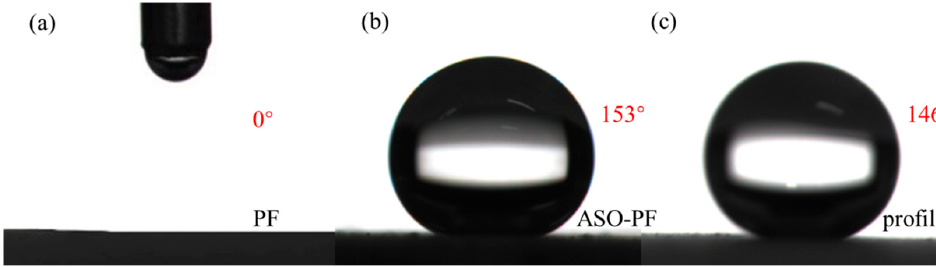
Figure 5. Water contact angle (WCA) of PF and ASO-PF: ( a ) WCA of PF xerogel surface, ( b ) WCA of ASO-PF xerogel surface, and ( c ) WCA of ASO-PF xerogel profile.